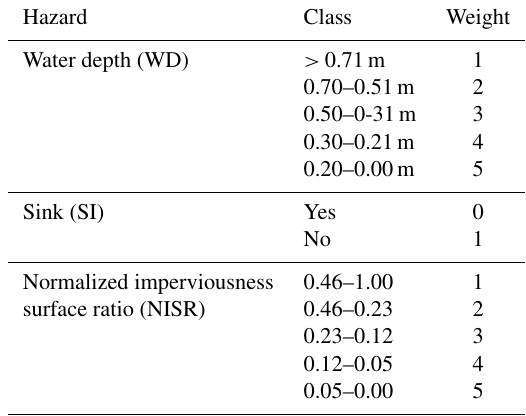
Table 1. Weights related to hazard classes for flood depth assigned to residential buildings, on sink map and on NISR